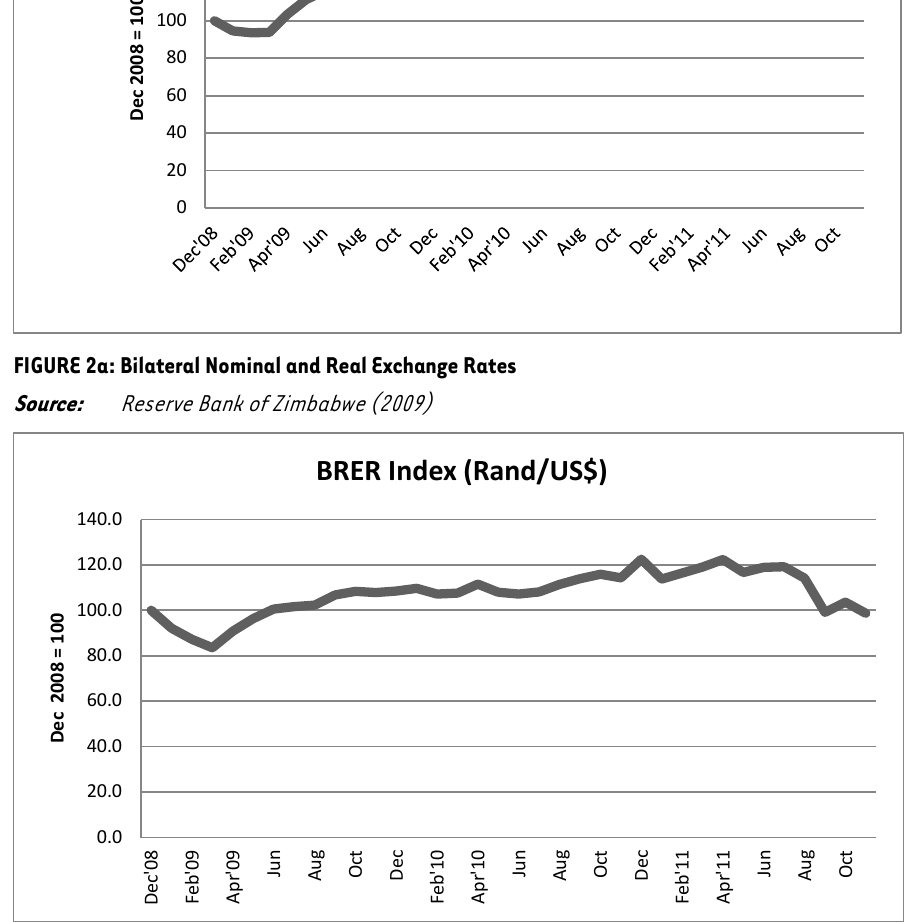
FIGURE 2b: Bilateral Nominal and Real Exchange Rates Source: Reserve Bank of Zimbabwe